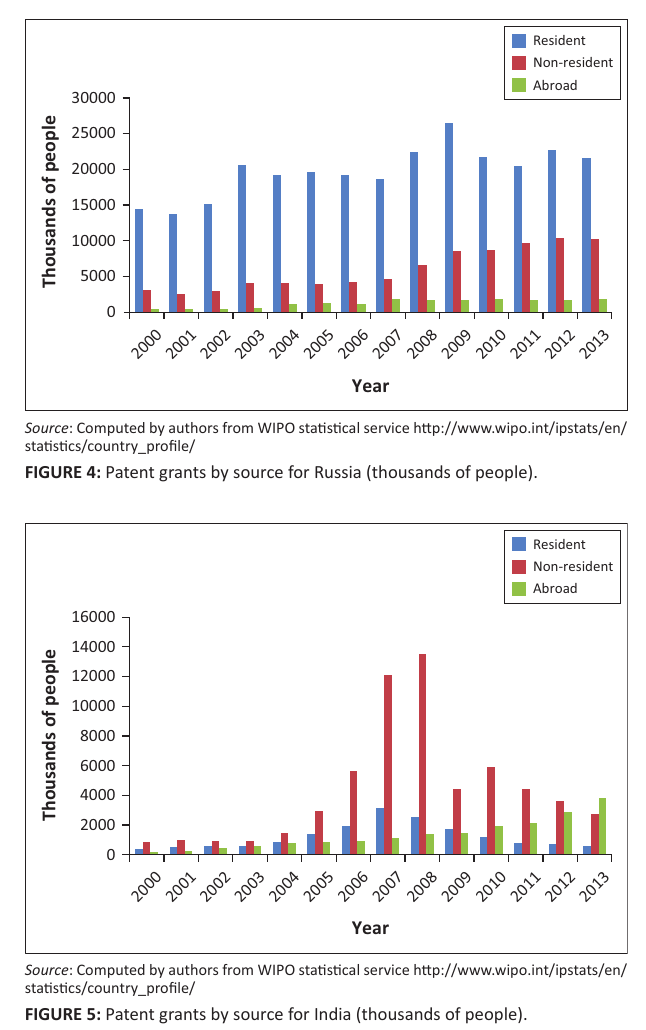
FIGURE 5: Patent grants by source for India (thousands of people).